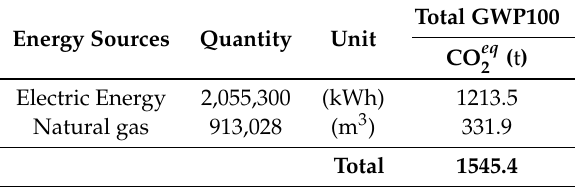
Table 5. Carbon footprint during the use phase of precast and cast-in-situ buildings.